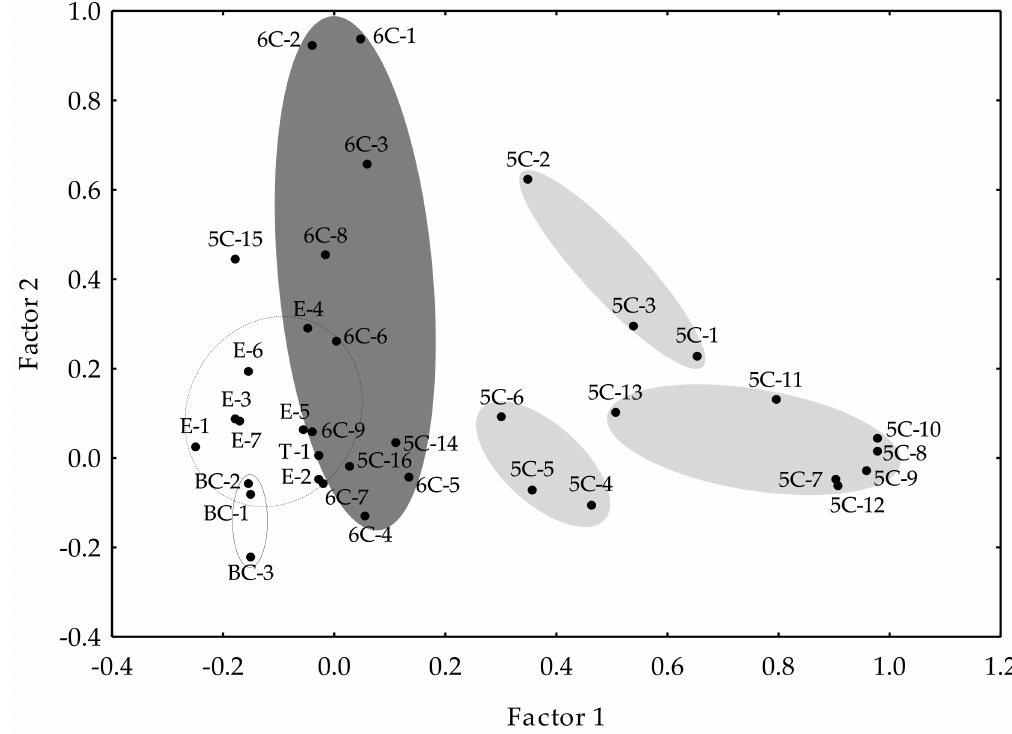
Figure 2. Factor analysis. Position of the volatile compounds in the oils from the WOGC cultivar subset on the first two factors using the normalized Varimax